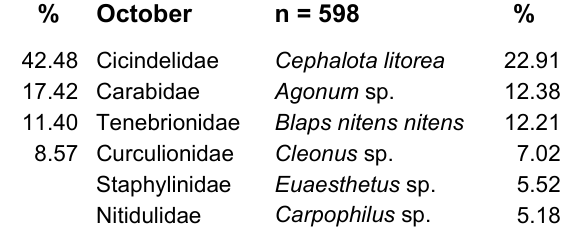
Abundant Species of the Coleoptera Found at El Bessila During the Two Seasons in All Transects April n = 3,954